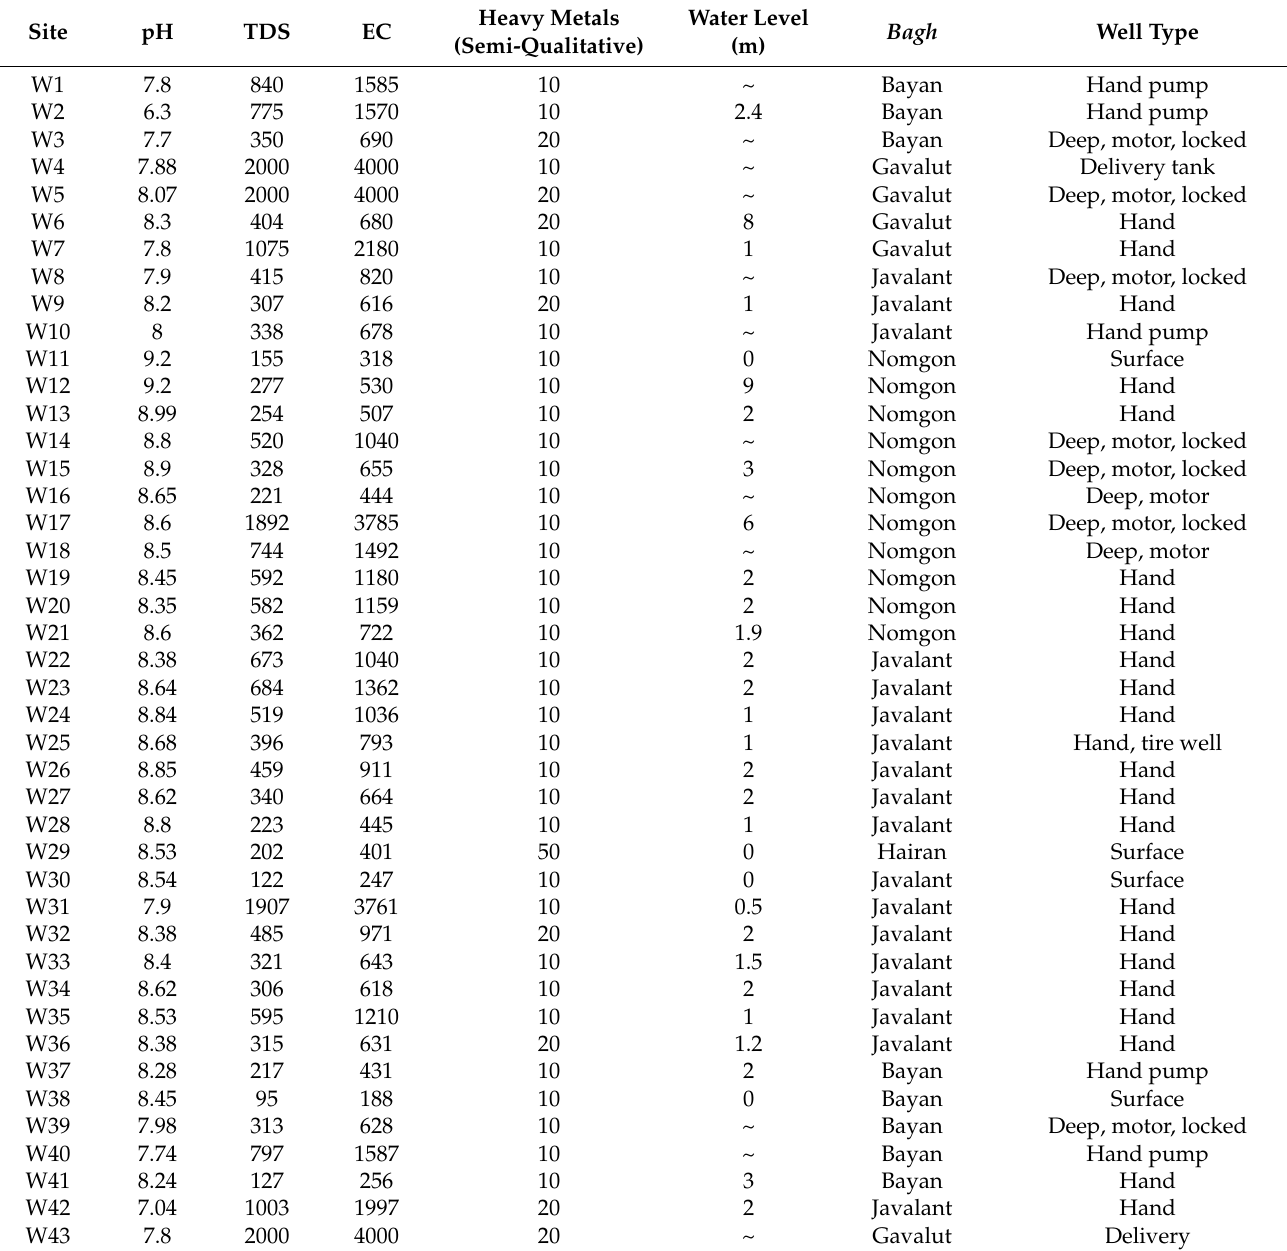
Table A2. Water quality and well